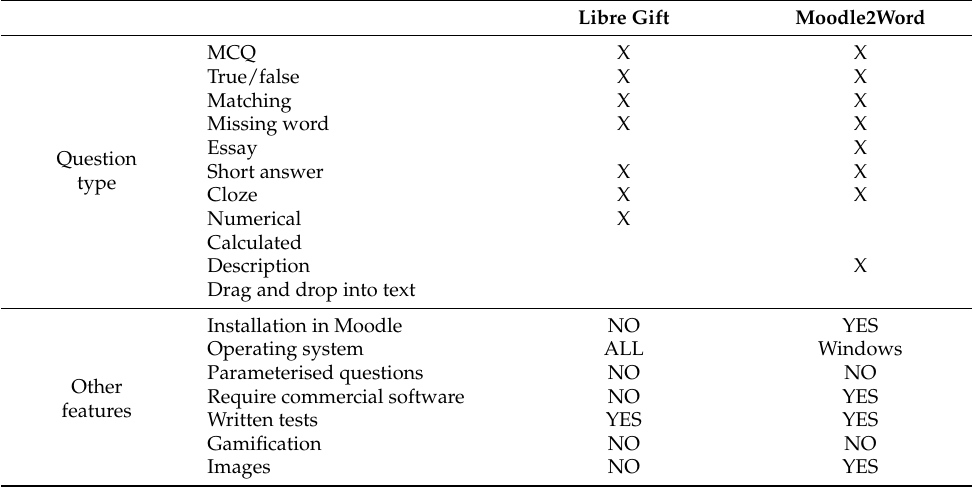
Table 3. Comparison of the question types handled by plugins developed in text processors.